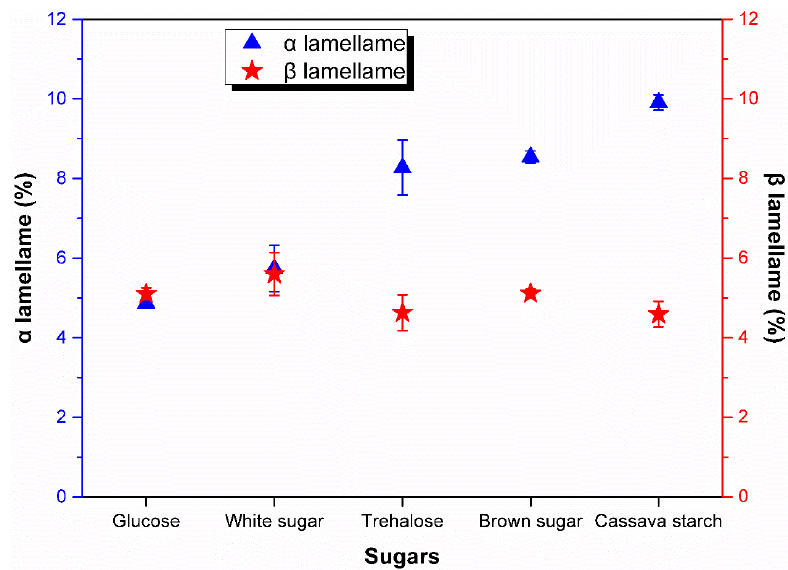
Figure 11. Effect of sugar substance on the fraction of α lamellae and β lamellae.